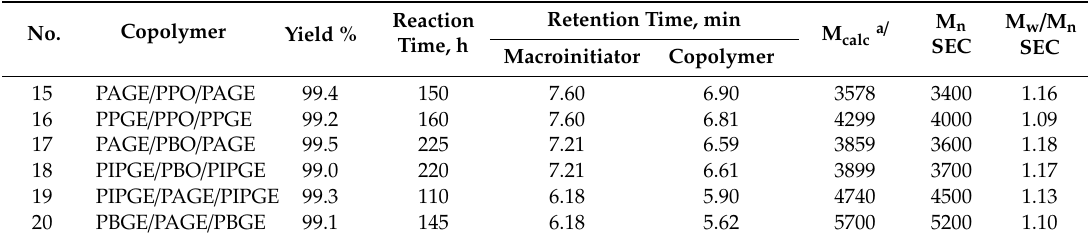
Table 2. Characterization data of triblock copolyether-diols by size exclusion chromatography (SEC)